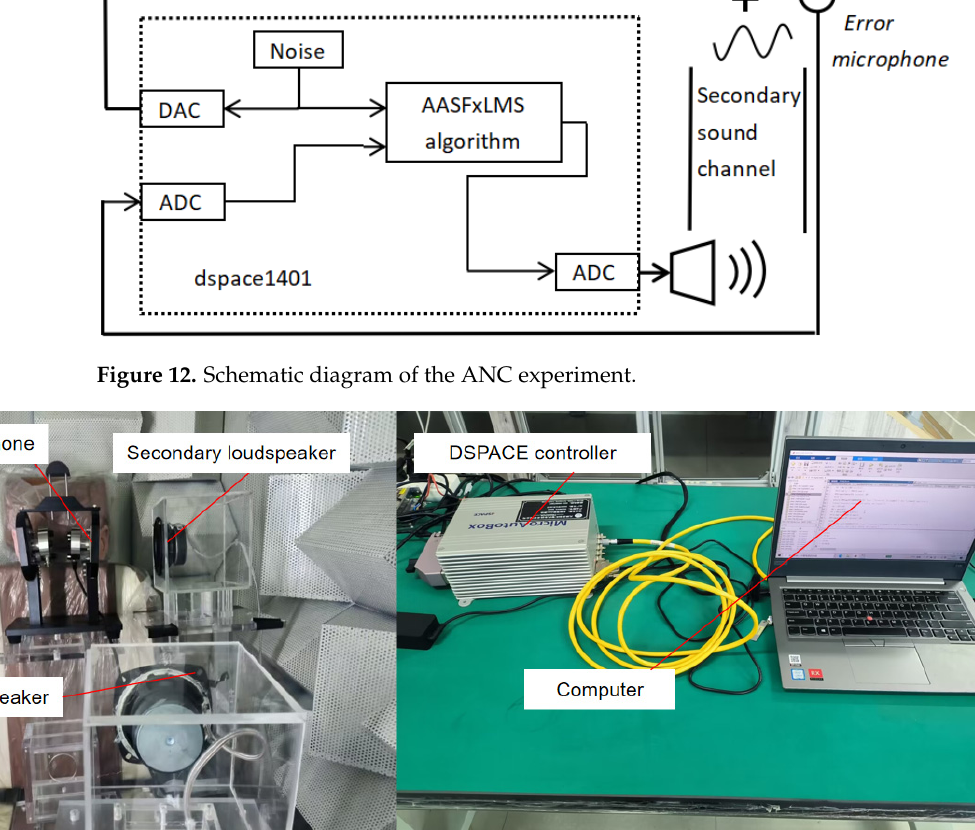
Figure 13. Hardware-in-the-loop ANC experimental platform.